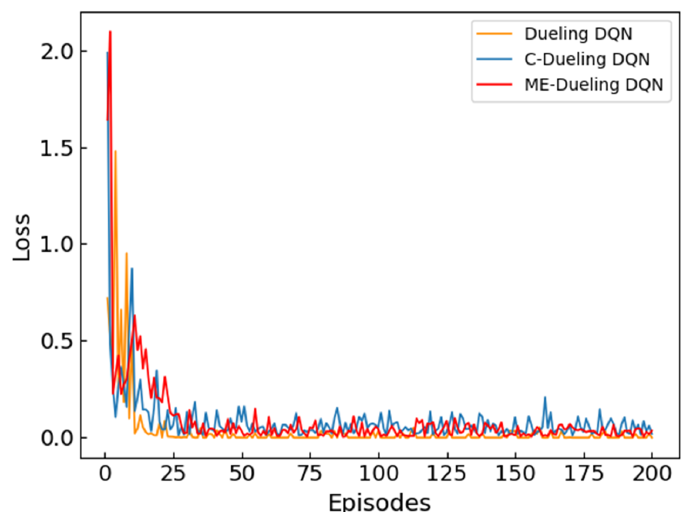
Figure 6. The loss change process of each algorithm.